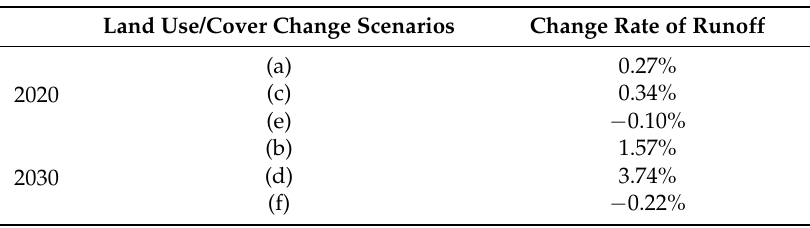
Table 14. Change of runoff under land use/cover